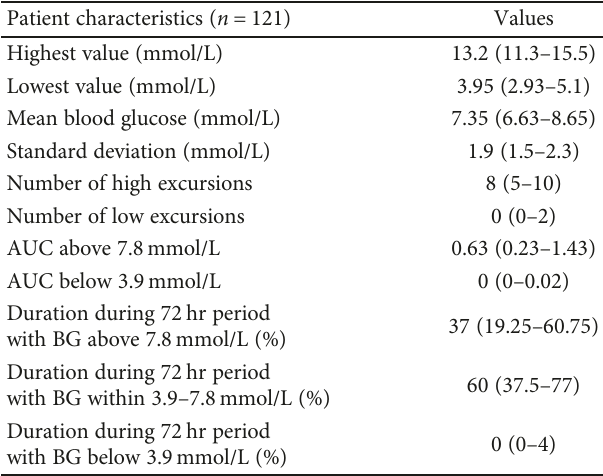
Table 2: Baseline continuous glucose-monitoring fi ndings of study